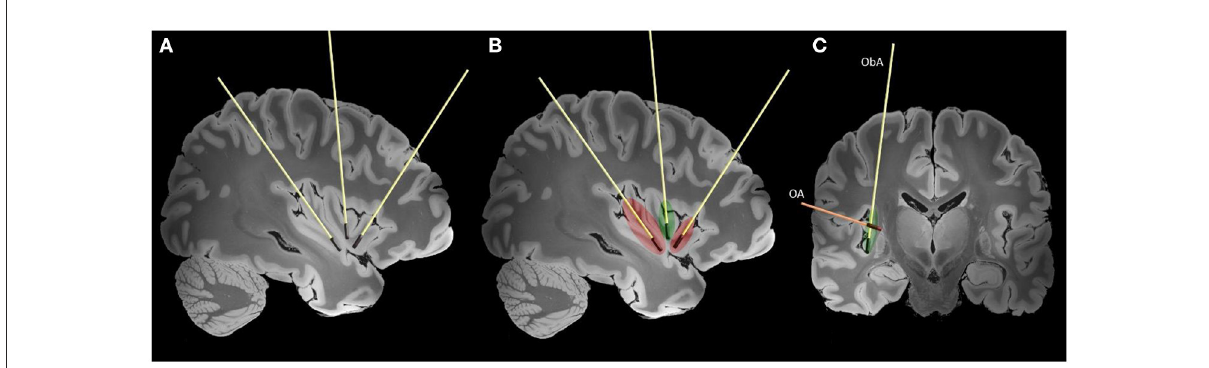
FIGURE3 Typically used trajectories for the LITT of the insula are shown on high-resolution 7-tesla T1 magnet resonance imaging (MRI) slices of the human brain (38). Laser interstitial therapy trajectories are shown on sagittal (A, B) and coronal (C) slices. The red color represents lesions created by the anterior and posterior laser probes and extent of the disconnection. The green color represents the additional ablation needed to achieve complete insular ablation. In figure the two main LITT trajectories are presented (ObA—oblique parasagittal approach, OA—orthogonal trans-opercular